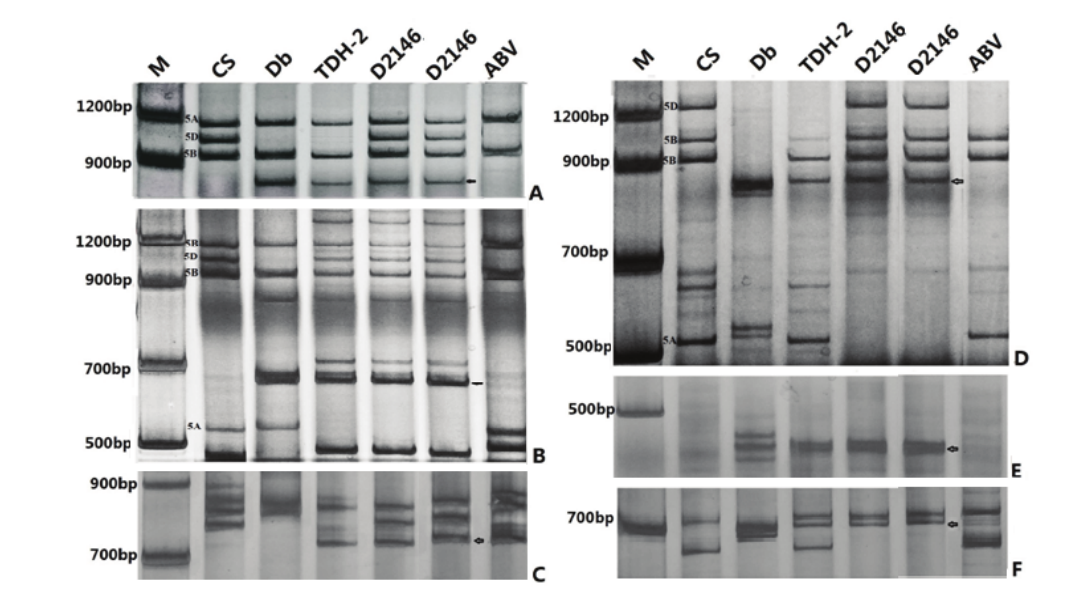
Figure 4. PCR amplification of molecular markers in wheat— D. breviaristatum lines. ( A ) TNAC1485; ( B ) TNAC1554; ( C ) BE443610; ( D ) TNA1567; ( E ) BE445380 and ( F ) BE604833. CS: “Chinese Spring” wheat; Db: D. breviaristatum ; TDH-2: wheat— D. breviaristatum partial amphiploid; D2146: 5AS.5V b L translocation line; ABV: Triticum turgidum , D. villosum amphiploid. The arrows indicate the D. breviaristatum specific